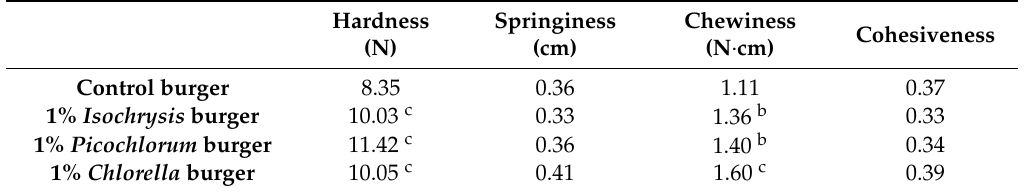
Table 3. Parameters obtained by texture analyzer for control burgers and fortified burgers with 1% of microalgae.